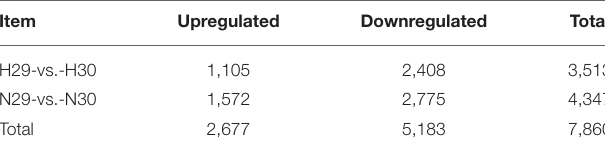
TABLE 3 | Statistics of upregulated or downregulated genes in each library.